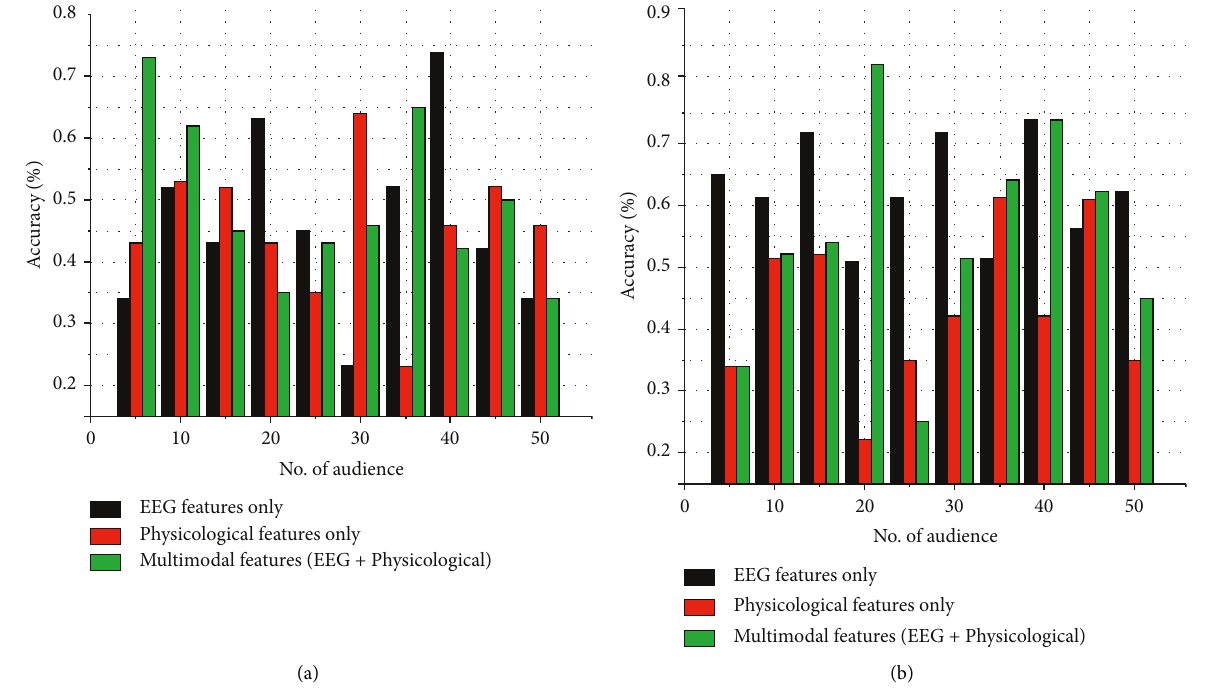
Figure 7: (a) Stimulus and (b) classification accuracy outcomes for the proposed MESDT.